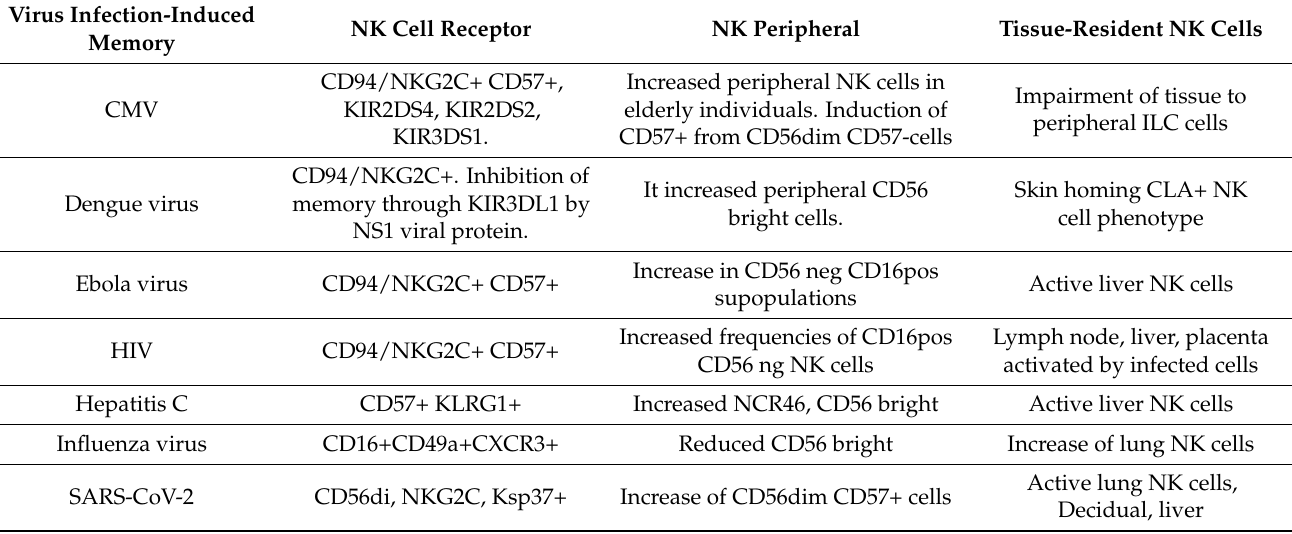
Table 3. Analysis between virus-induced memory NK cells and peripheral NK and tissue-resident NK.